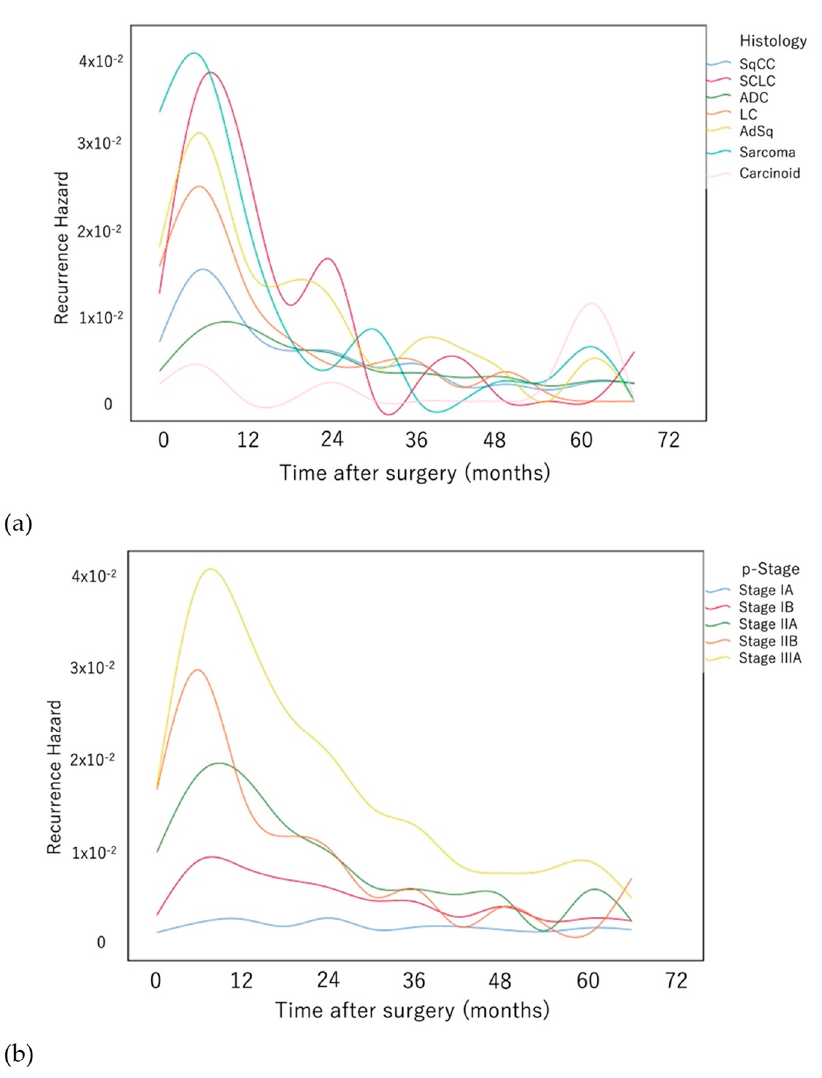
Figure 3. Comparison of the recurrence hazard functions associated with ( a ) histology and ( b ) pathological stage. (Abbreviations: SqCC, squamous cell lung carcinoma; SCLC, small cell lung cancer; ADC, adenocarcinoma; LC, large cell lung carcinoma; AdSq, adenosquamous lung carcinoma.).